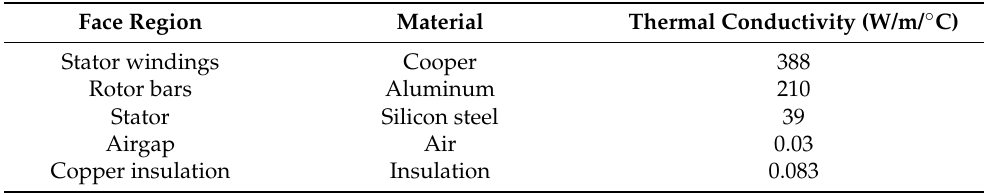
Table 4. Induction motor (IM) materials’ thermal properties.